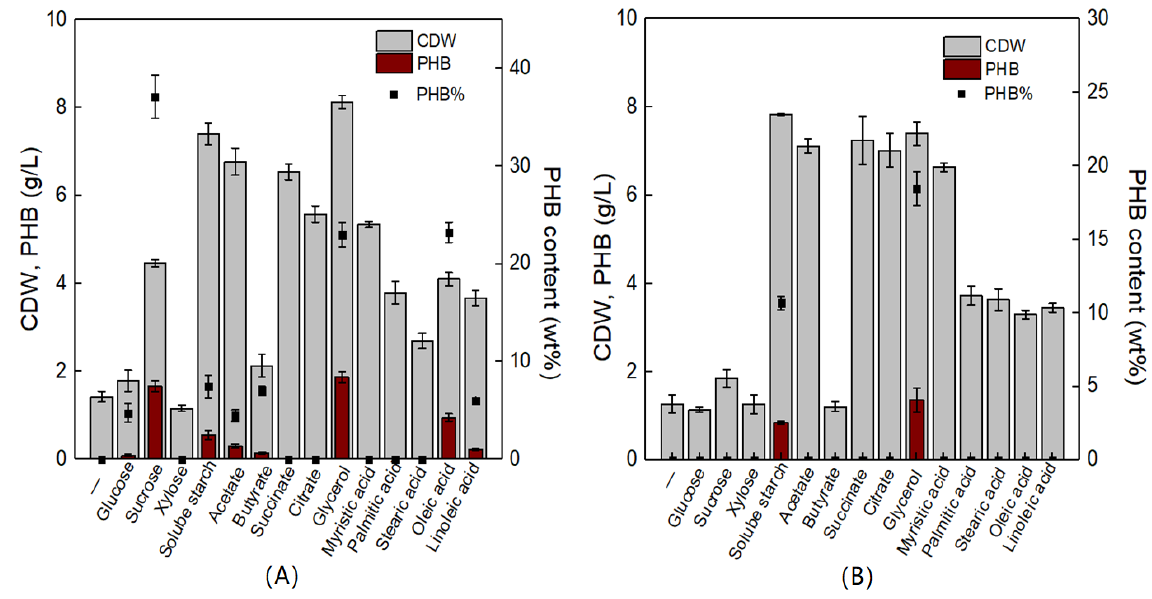
Figure 3. CDW, PHB concentration, and PHB content profiles of V. alginolyticus LHF01 ( A ) and LHF02 ( B ) cultivated in TYS medium with different carbon sources. Data are expressed as averages and standard deviations of three parallel experiments.